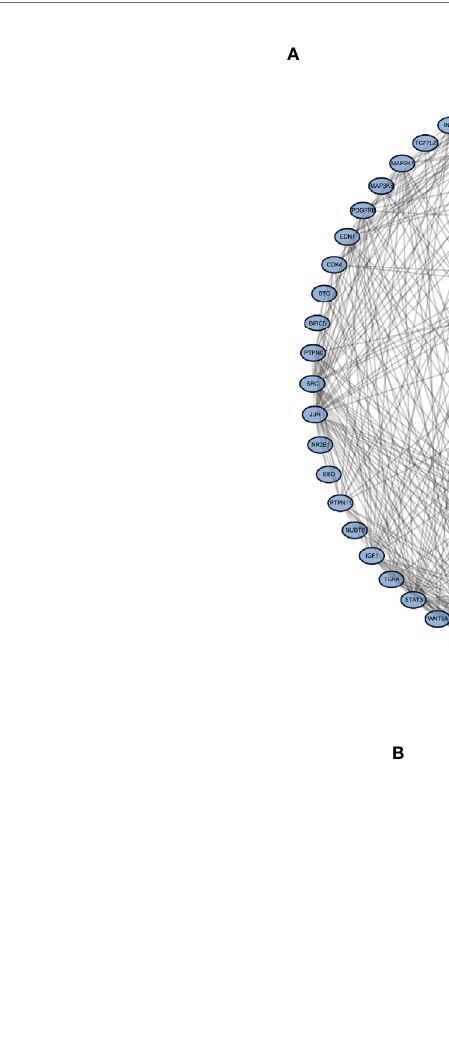
FIGURE 2 | Identi fi cation of PPI network of the DEGs. (A) Visualization of the PPI network using STRING database and Cytoscape software. (B) Interactions of the top ten hub